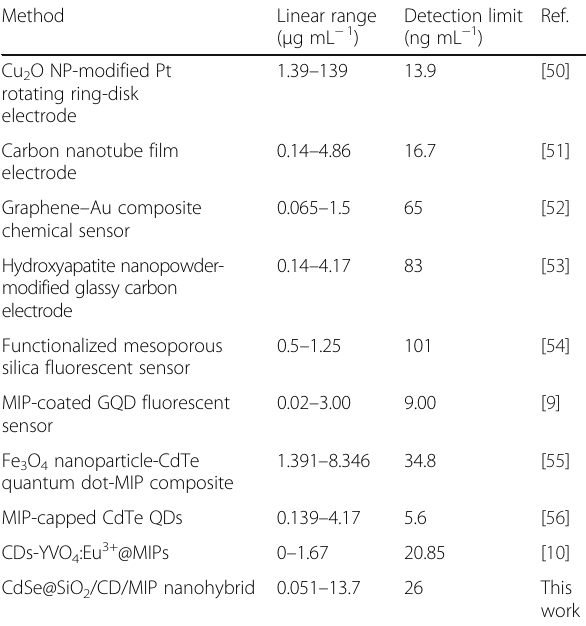
Table 1 Comparison of the linear ranges and detection limits towards 4-NP for various literature